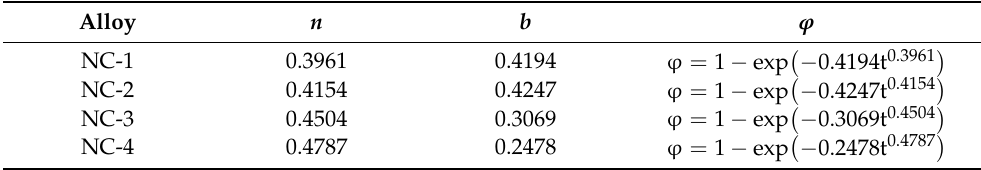
Table 9. The conductivity equation of alloys aged at 500 °C.